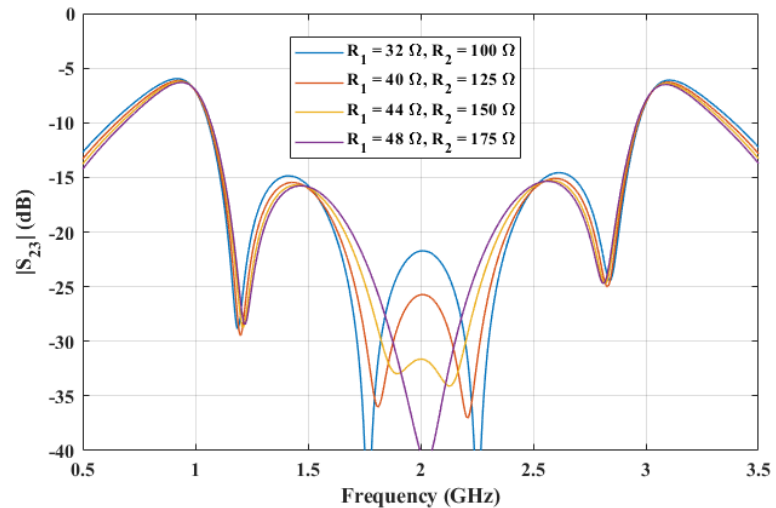
Figure 18. Variation of S 23 (dB) for θ c = 55 ◦ with different isolation